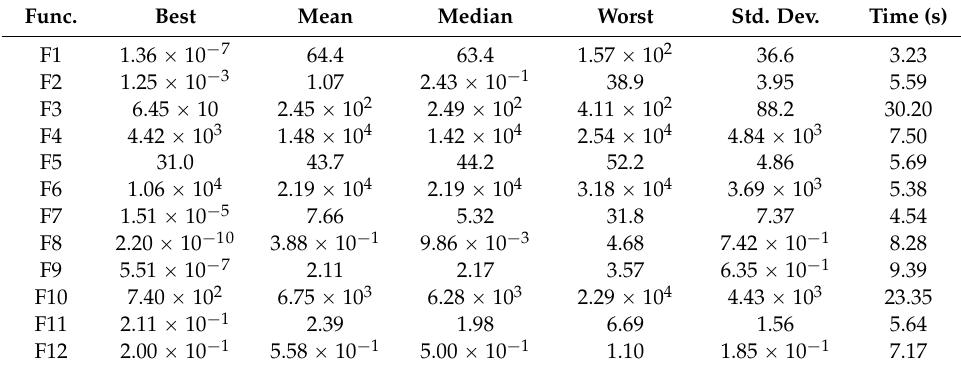
Table 3. Statistical results for AFWA.